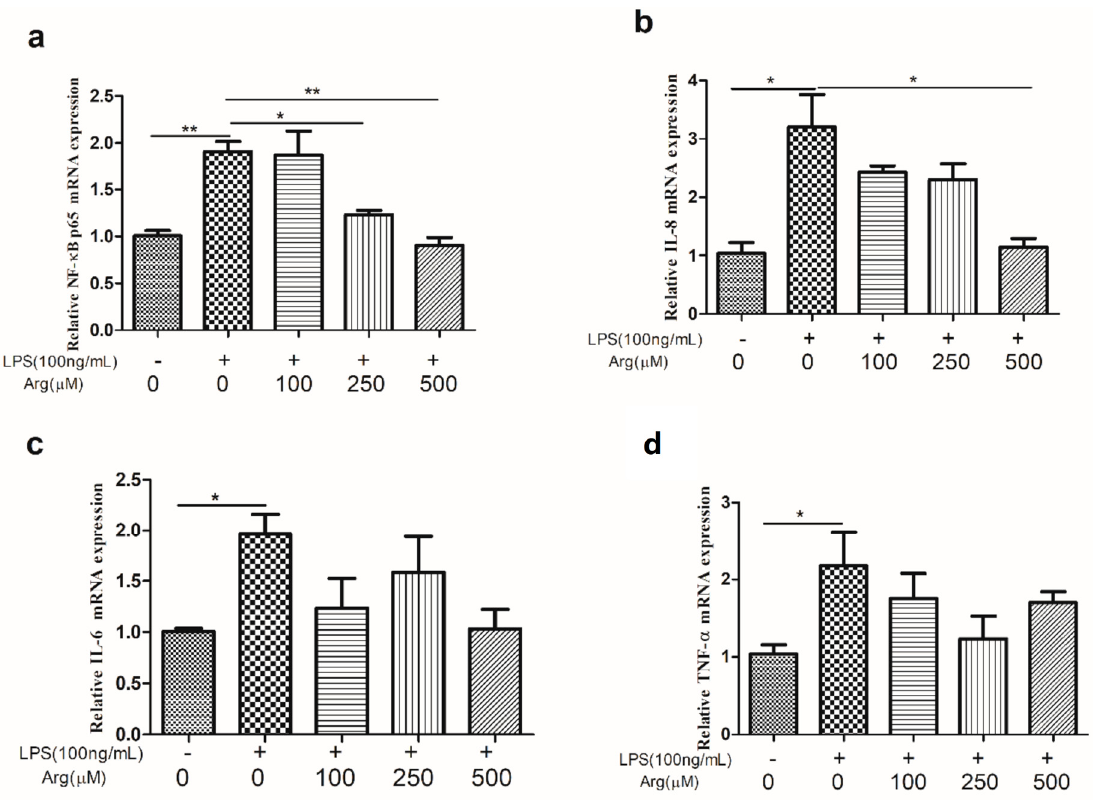
Figure 4. E ff ect of arginine on pro-inflammatory cytokines in LPS-treated IPEC-J2 cells. The abundance of ( a ) NF- κ Bp65, ( b ) IL-8, ( c ) IL-6, and ( d ) TNF- α in IPEC-J2 cells exposed to LPS (0 or 100 ng / mL) and LPS-treated cells were co-incubated with arginine (0, 100, 250, or 500 µ M) for 24 h. Data were representative of triplicate experiments and expressed as the mean ± SEM.* p < 0.05, ** p < 0.01. NF- κ Bp65, nuclear factor- κ Bp65; IL-8, interleukin-8; IL-6,